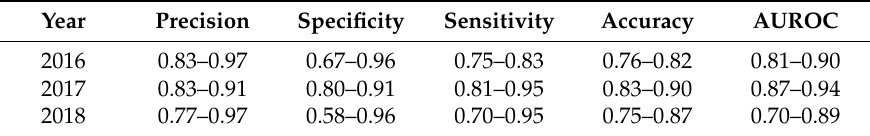
Table 3. Classification precision, specificity, sensitivity, overall accuracy, and area under receiver operating characteristic curve (AUROC) achieved in classifying healthy and SDS-infected soybean quadrats. This table shows the range, i.e., the minimum and maximum values obtained for these parameters in all years.